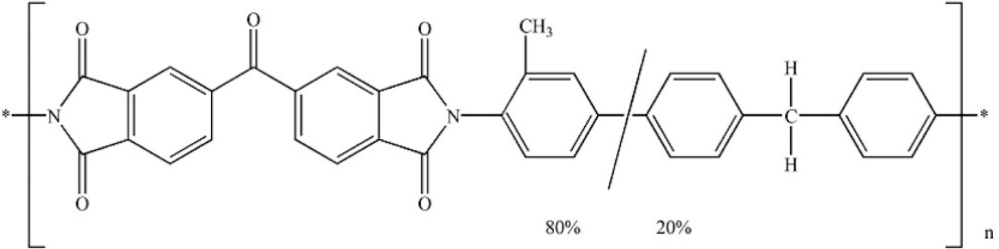
Figure 1. Chemical structure of BTDA–TDI/MDI ( Ρ 84) co-polyimide.